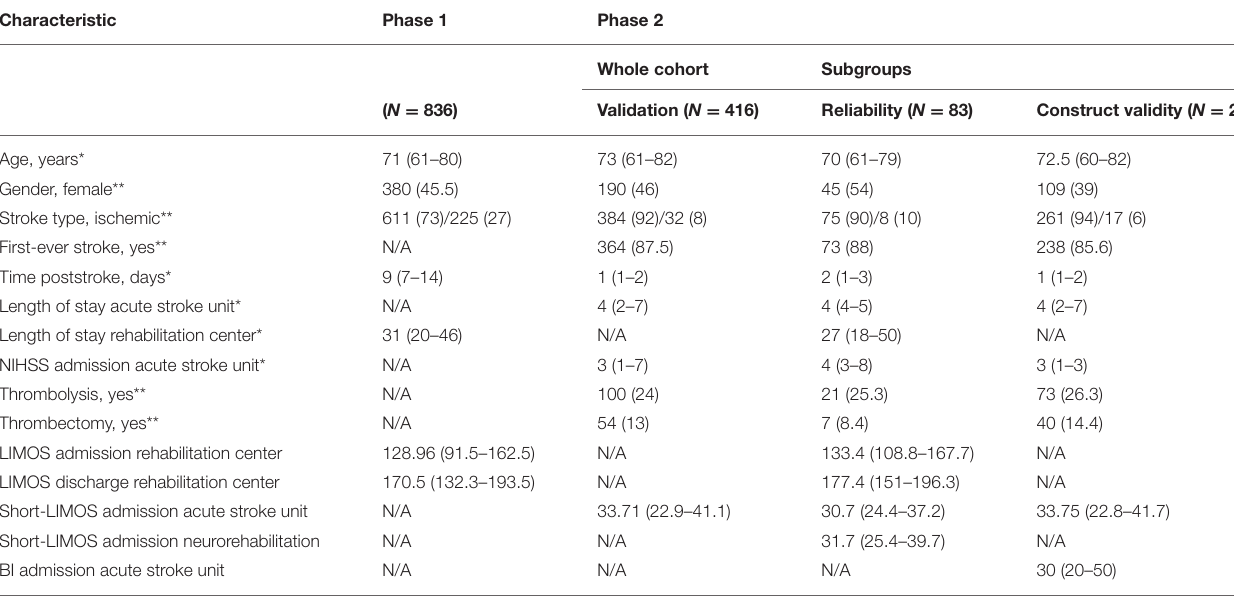
TABLE 1 | Characteristics of the patient’s study sample in Phase 1 and Phase